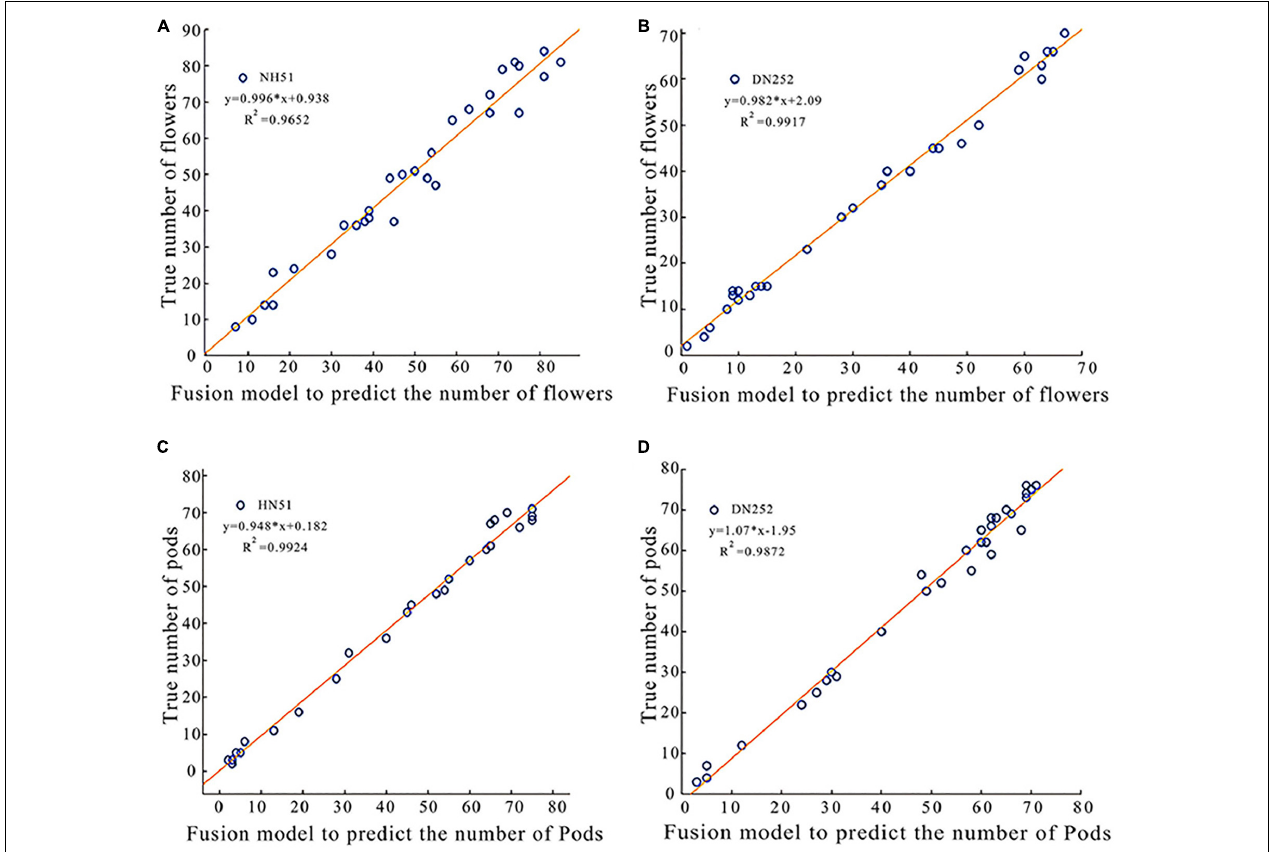
FIGURE 5 | Plots of linear correlation between the fusion model predicted soybean flowers and pods and true values of manual counting. (A) A plot of linear correlation between the fusion model-predicted soybean flowers of variety HN51 and true values of manual counting. (B) A linear correlation plot of the fusion model predicted the true value of soybean flowers and manual counting for variety DN252. (C) A plot of linear correlation between the fusion model-predicted soybean pod of variety HN51 and the true value of manual counting. (D) A plot of linear correlation between the fusion model-predicted soybean pod of variety DN252 and the true value of manual